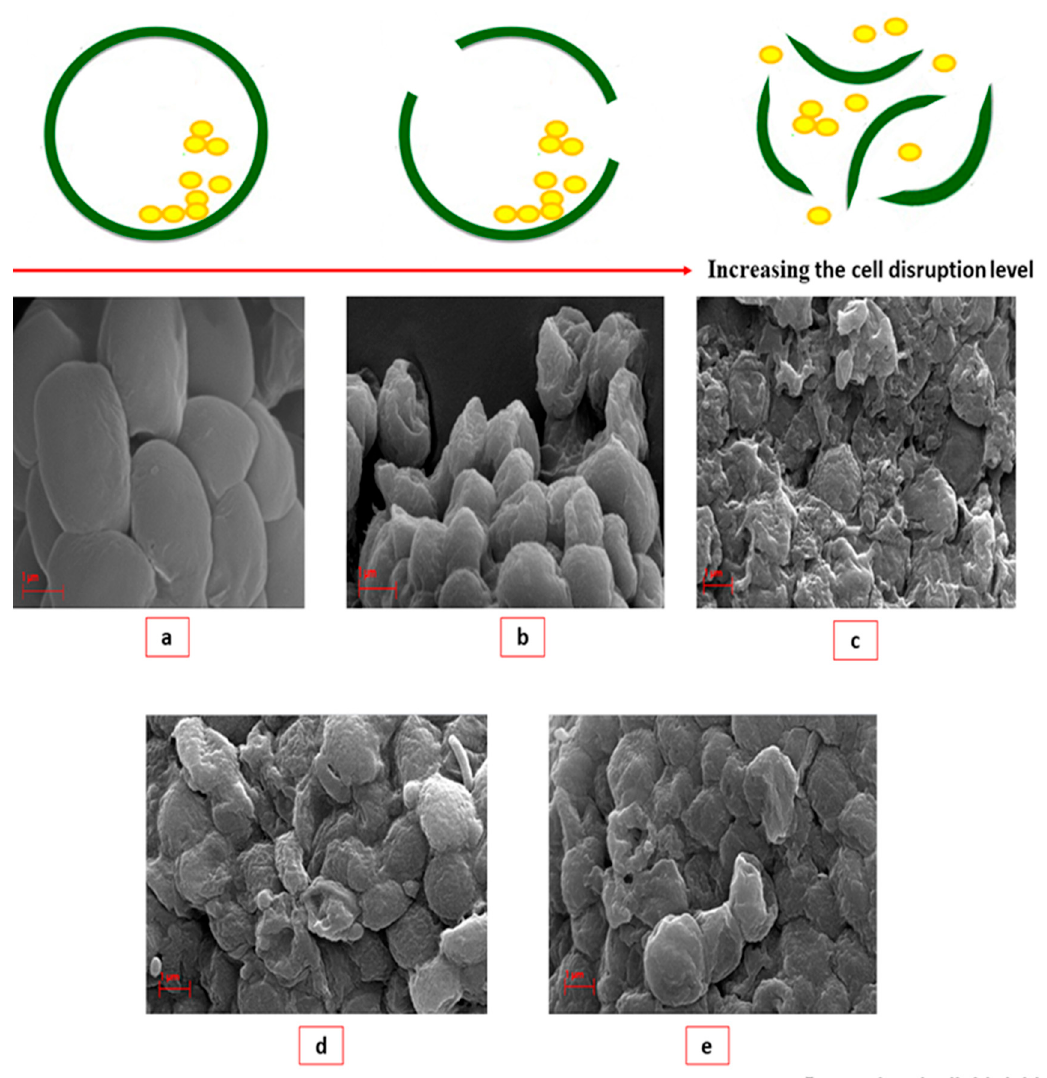
Figure 9. The picture of the effect of the cell cracks on the lipid recovery using SEM micrograph (10 k) for Nannochloropsis sp. microalgae ( a ) before MAE, ( b ) at MAE conditions of 100 °C and 3 min, ( c ) at MAE conditions of 100 °C and 30 min, ( d ) at MAE conditions of 60 °C and 30 min and ( e ) at MAE conditions of 80 °C and 30 min.